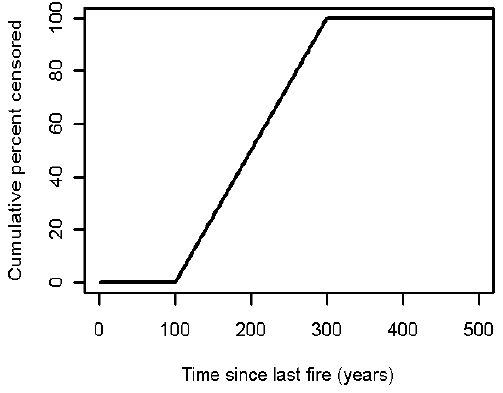
Figure 1. Cumulative probability function of time since fire (TSF) censorship.